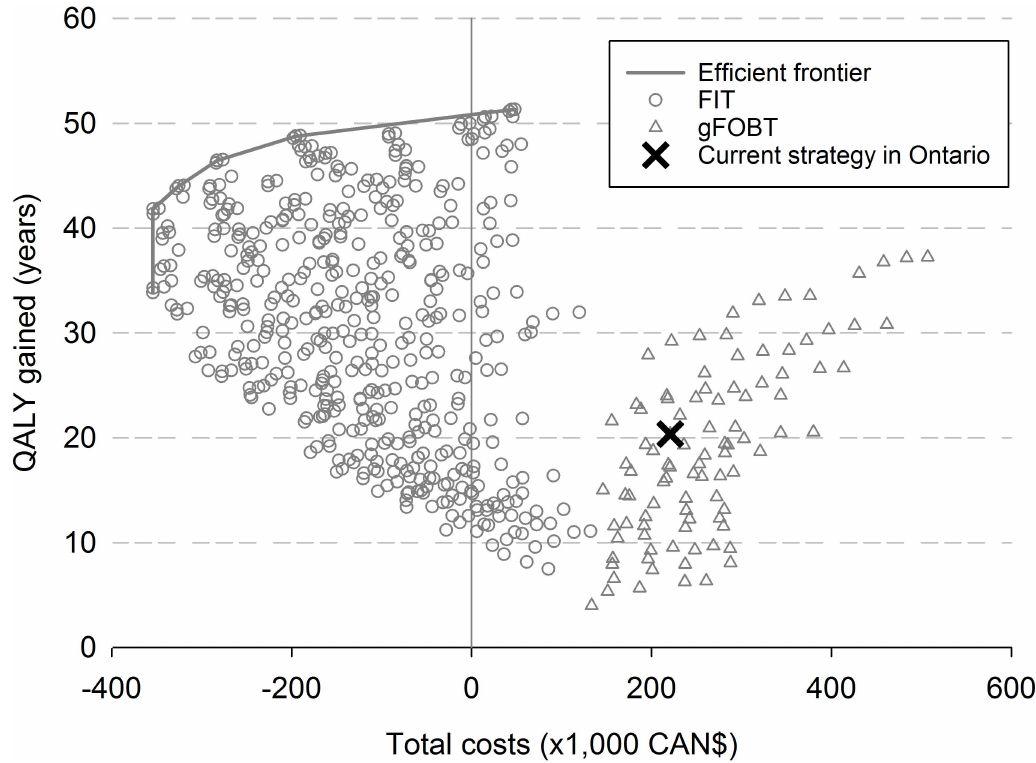
Fig 1. Discounted total costs and discounted QALYs gained, per 1,000 participants, of the gFOBT and FIT screening strategies compared to no screening. QALY: quality adjustedlife year; gFOBT: guaiac fecal occult blood test; FIT: fecal immunochemical test. Current screeningstrategy in Ontario: biennialgFOBT, betweenage 50–74. Strategiesare varied by age at starting screening, age at stoppingscreening,screeninginterval, and FIT cut-off level. The cost-effective strategies are connectedby the efficient frontier. Costs (expressed in 2013 Canadiandollars)and QALYs are discountedby 3% per